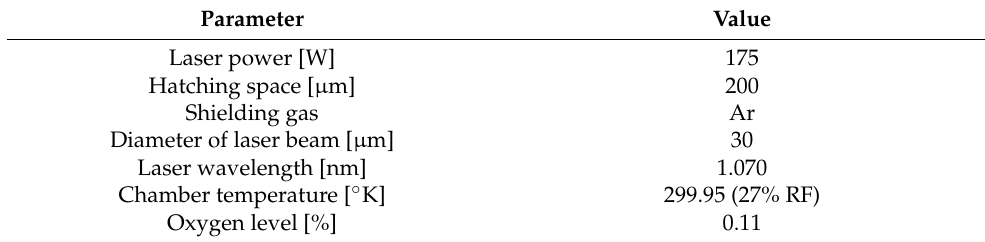
Table 1. The SLM process parameters.